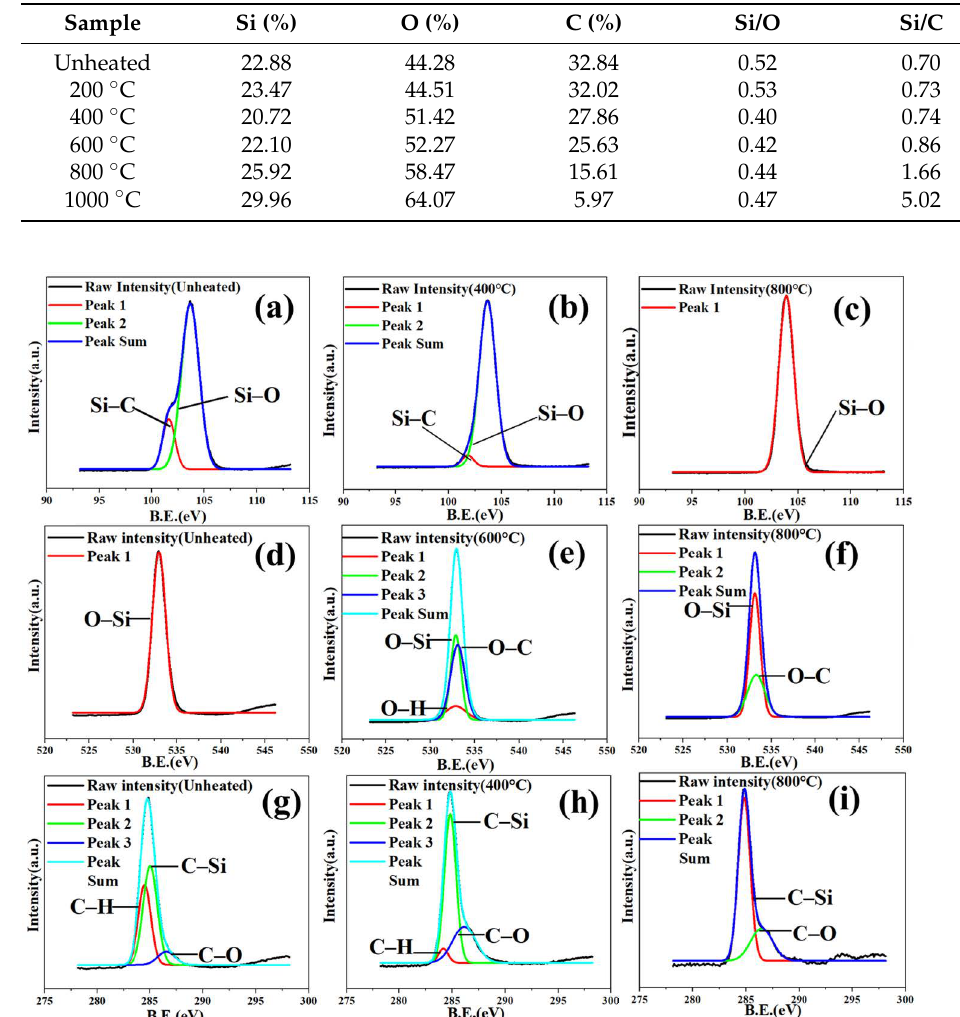
Table 3. Compositions of the silica aerogel samples calculated by XPS results.